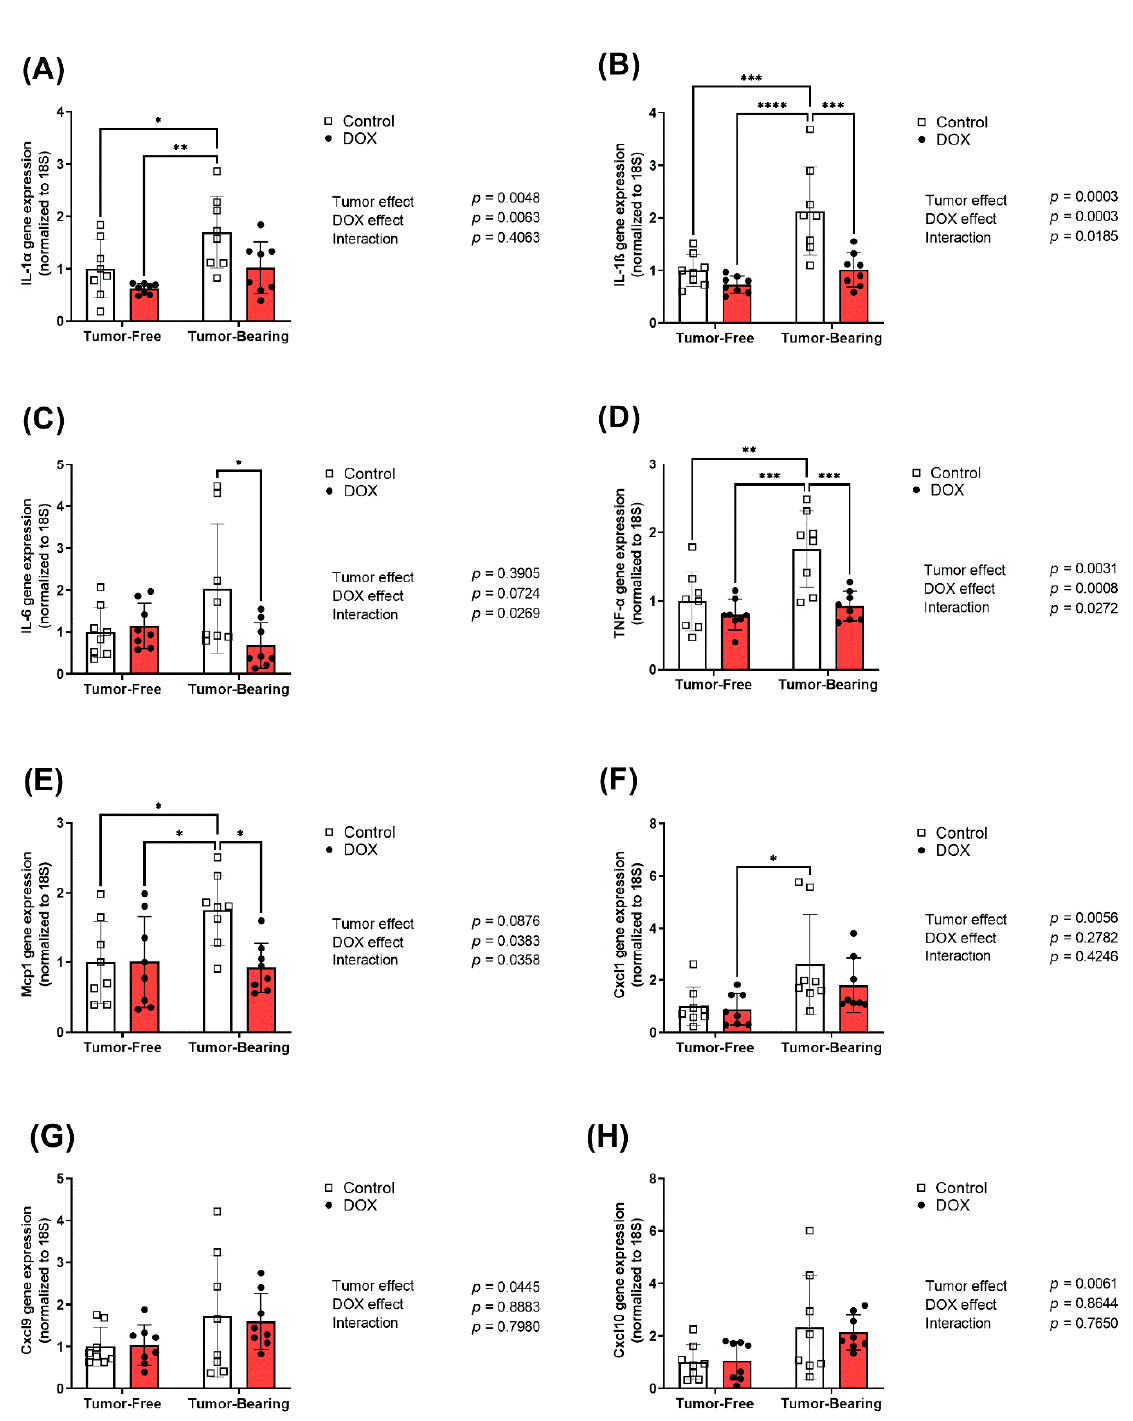
Figure 5. Chronic administration of DOX (4 mg/kg/week) for 3 weeks abrogates tumor-induced upregulation of inflammatory markers in the kidney. Kidneys were harvested from both tumor-free and EL4 lymphoma tumor-bearing juvenile C57BL/6N mice one week following the administration of 4 mg/kg/week of DOX or equivalent volume of sterile saline for 3 weeks ( n = 8 per group). Following the extraction of total RNA, renal mRNA expression of ( A ) IL-1 α , ( B ) IL-1 β , ( C ) IL-6, ( D ) TNF- α , ( E ) Mcp-1, ( F ) Cxcl1, ( G ) Cxcl9, and ( H ) Cxcl10 were determined by real-time PCR. Values were normalized to 18S rRNA and expressed relative to saline-treated tumor-free mice. Values are shown as means ± SEM. Two-way ANOVA table demonstrates DOX, tumor, and interaction effects on the mRNA expression. Statistical significance of pairwise comparisons was determined using two-way ANOVA with Tukey’s post hoc analysis (* p < 0.05, ** p < 0.01, and *** p < 0.001, **** p < 0.0001).